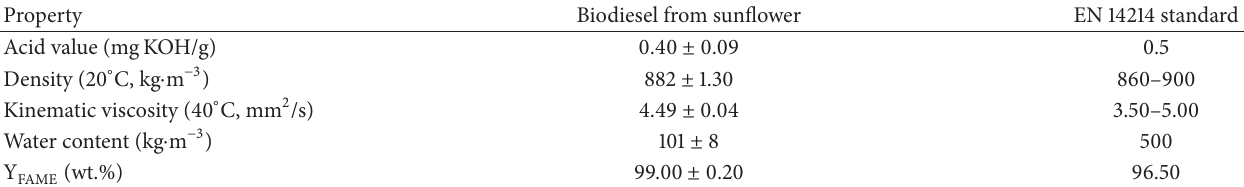
Table 5: Properties of sunflower biodiesel. Data are presented as mean ± standard deviation, 𝑛 = 3 .